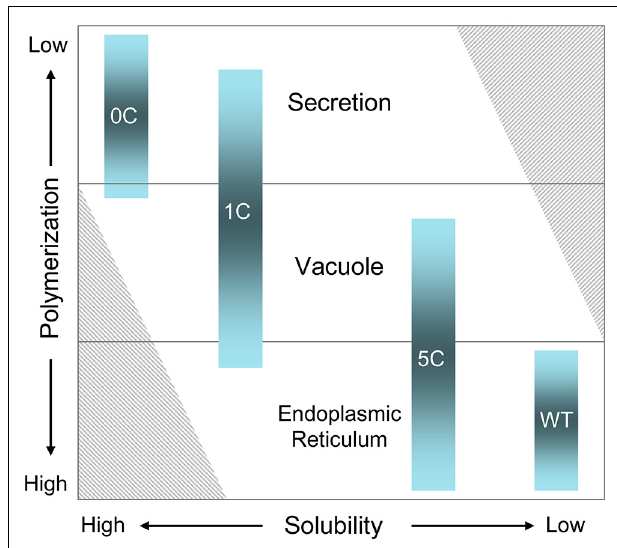
FIGURE 6 |A model for the relationships between solubility, polymerization and subcellular localization of seed storage proteins, based on the behaviors ofWT, 5C-, 1C-, and 0C- γ -zein. The shaded columns indicate the subcellular localization of each construct, where the relative space occupied in each of the three locations is roughly proportional with the observed average distributions.The striped areas at lower left and upper right indicate situations predicted to be impossible. For simplicity, the model does not take into consideration other factors that determine or influence the subcellular localization, such as for example the short vacuolar sorting signals identified in several soluble 2S albumins and 7/11S